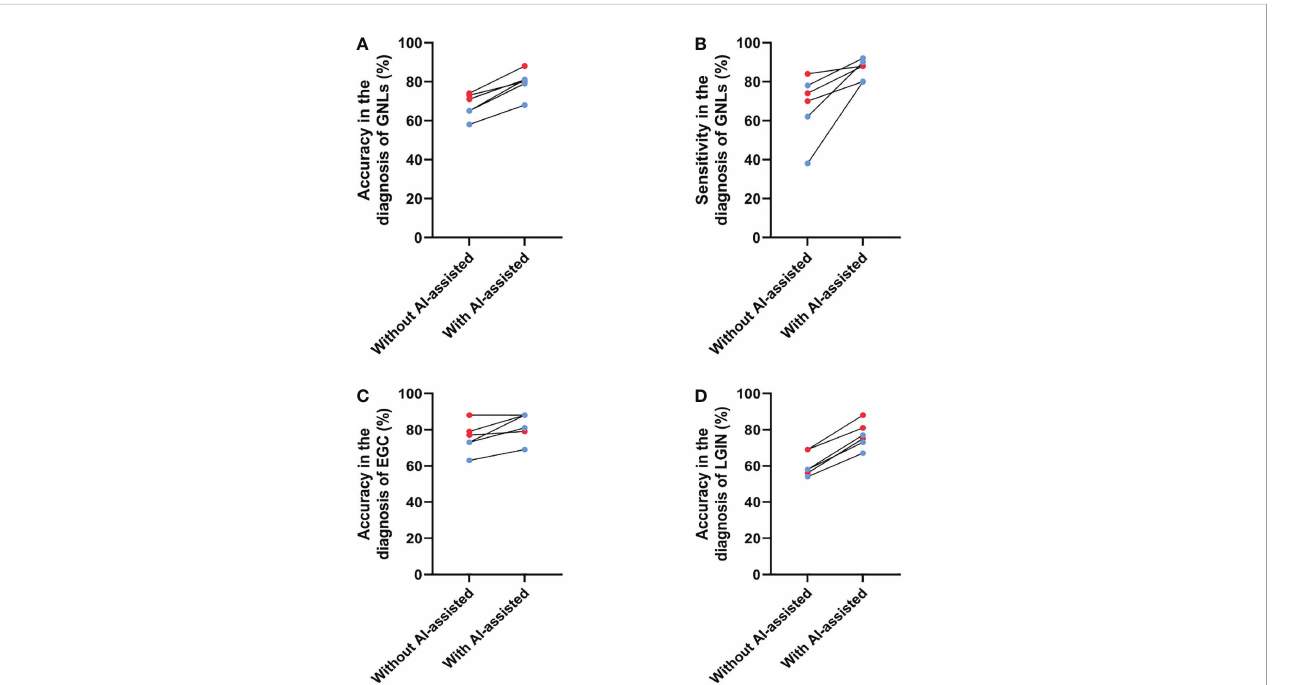
FIGURE 5 Changes in the diagnostic performance for GNLs of endoscopists before and after CNN1 assistance. (A) Changes in accuracy for GNLs of endoscopists before and after CNN1 assistance. (B) Changes in sensitivity for GNLs of endoscopists before and after CNN1 assistance. (C) Changes in the accuracy for EGC of endoscopists before and after CNN1 assistance. (D) Changes in the accuracy for LGIN of endoscopists before and after CNN1 assistance. Red dots represent senior endoscopists, and blue dots represent junior endoscopists. AI, arti fi cial intelligence; GNLs, gastric neoplastic lesions; CNN, convolutional neural network; EGC, early gastric cancer; LGIN, low-grade intraepithelial neoplasia.